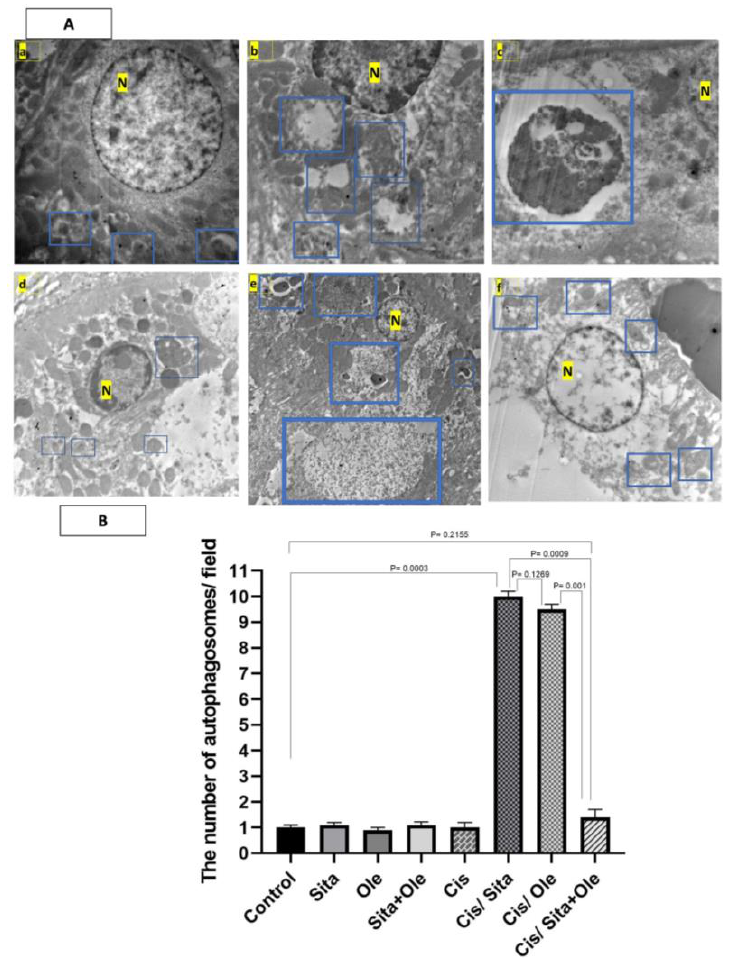
Fig. 6. (A) Electron microscopic analysis of autophagy in the monotherapy with Sita (a-c) or OLE (d-f) : Selected micrographs show the accumulation of autophagosomes in renal cells, where some autophagosomes are enclosing cytosol others are enveloping organelles. Also, renal cells display varying degree of cellular damage in alignment with the impaired autophagic flux. (B) Quantification of autophagosomes. The number of autophagosomes/field was determined in electron micrographs from at least 3 randomly selected visual fields. Data are expressed as means ±